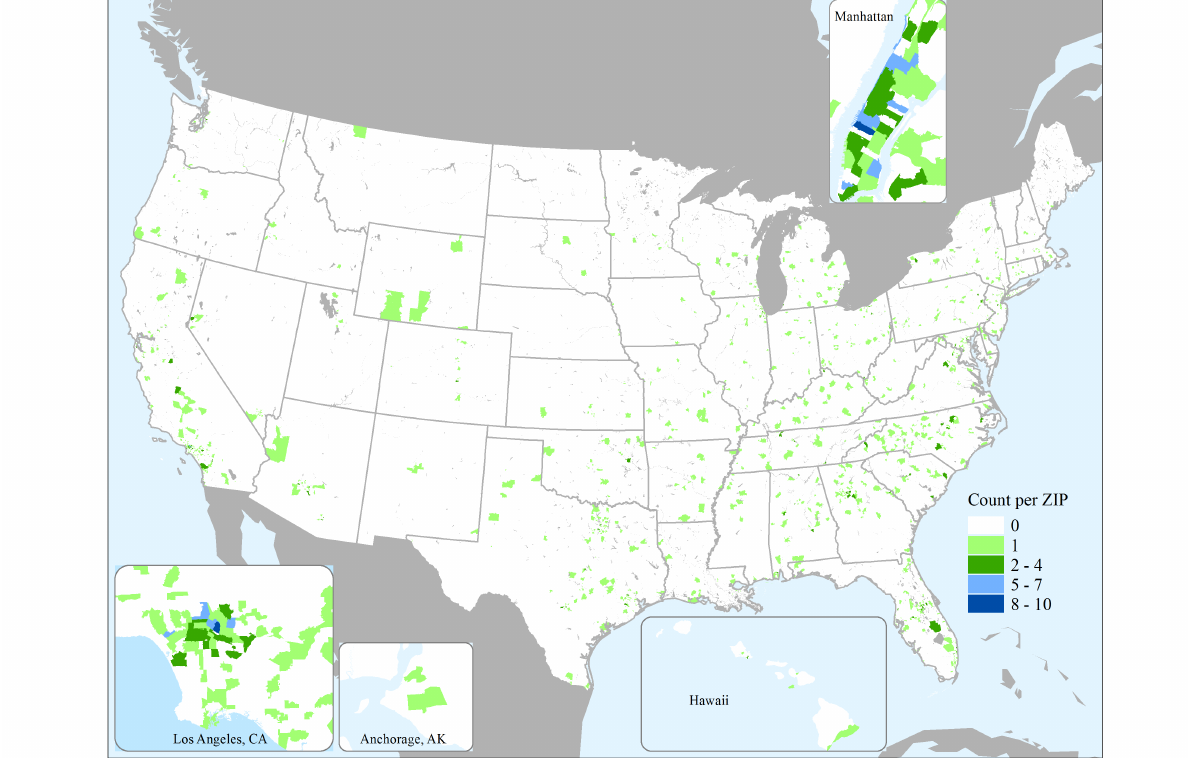
Figure 1. US distribution of sample by ZIP